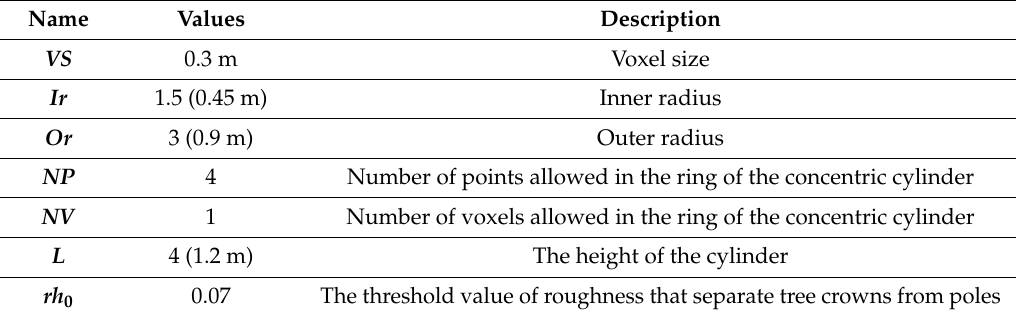
Table 2. Parameter settings applied to our two test sites.